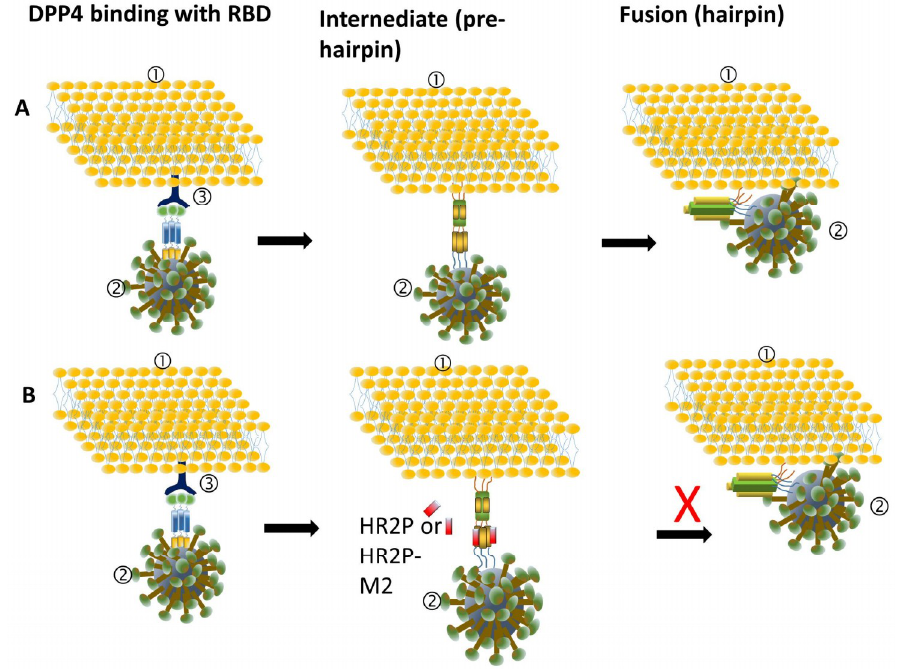
Figure 4. Schematic representation of the inhibition mechanism of HR2P and HR2P-M2. 1 (cid:13) Target cell membrane; 2 (cid:13) MERS-CoV; 3 (cid:13) dipeptidyl peptidase-4 (DPP4). ( A ) Mechanism of normal binding between a host cell and MERS-CoV. MERS-CoV enters the host cell by binding the viral particle via the RBD in spike protein to the cellular receptorDPP4 on the surface of the host cell. The HR2 binds to the HR1 to form a six-helix bundle (6-HB) fusion core, which brings viral and cell membranes into close apposition for fusion. ( B ) HR2P and HR2P-M2 block six-bundle fusion core formation between HR1 and HR2 peptides by binding to the viral S protein HR1